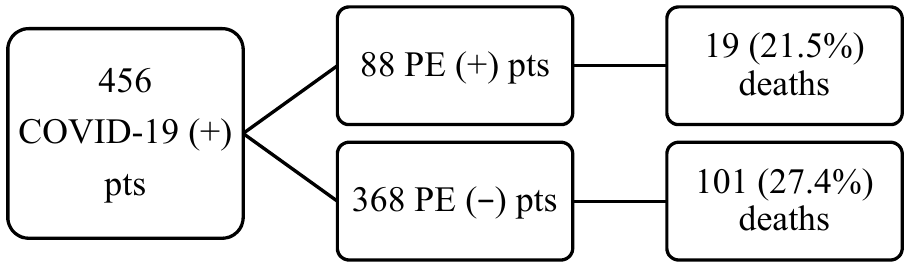
Figure 1. Flow of patients in the study.